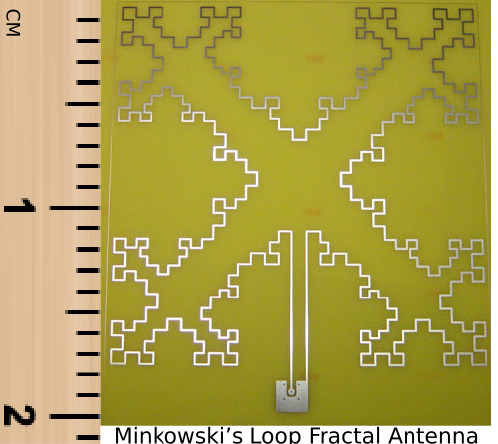
Figure 19. Fabricated antenna photography from a Minkowski fractal curve scheme.